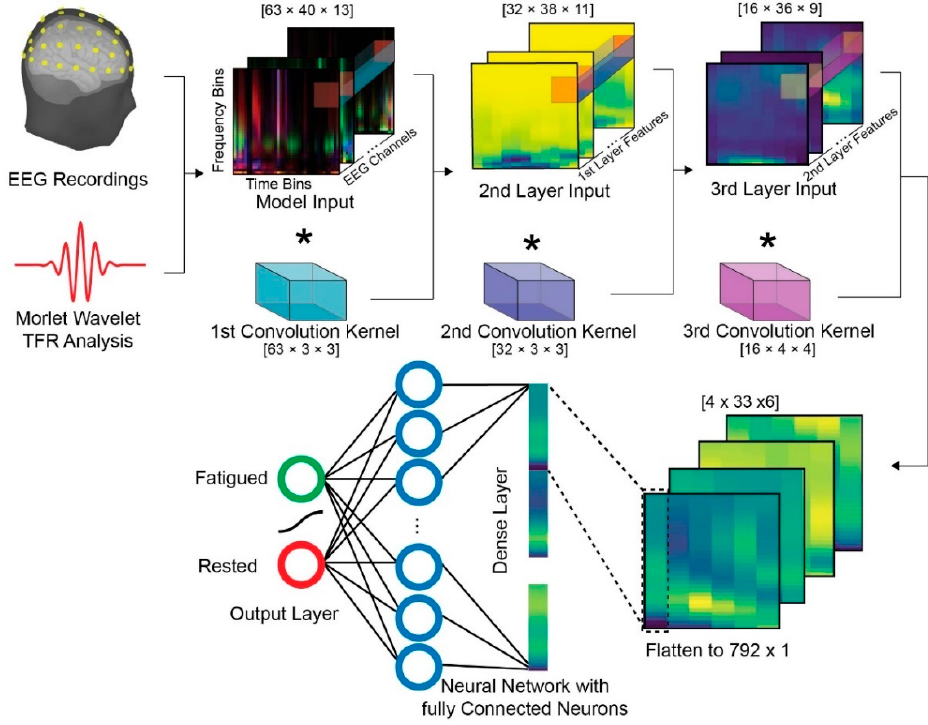
Figure 1. A schematic of the proposed framework. The symbolizes the convolution function.